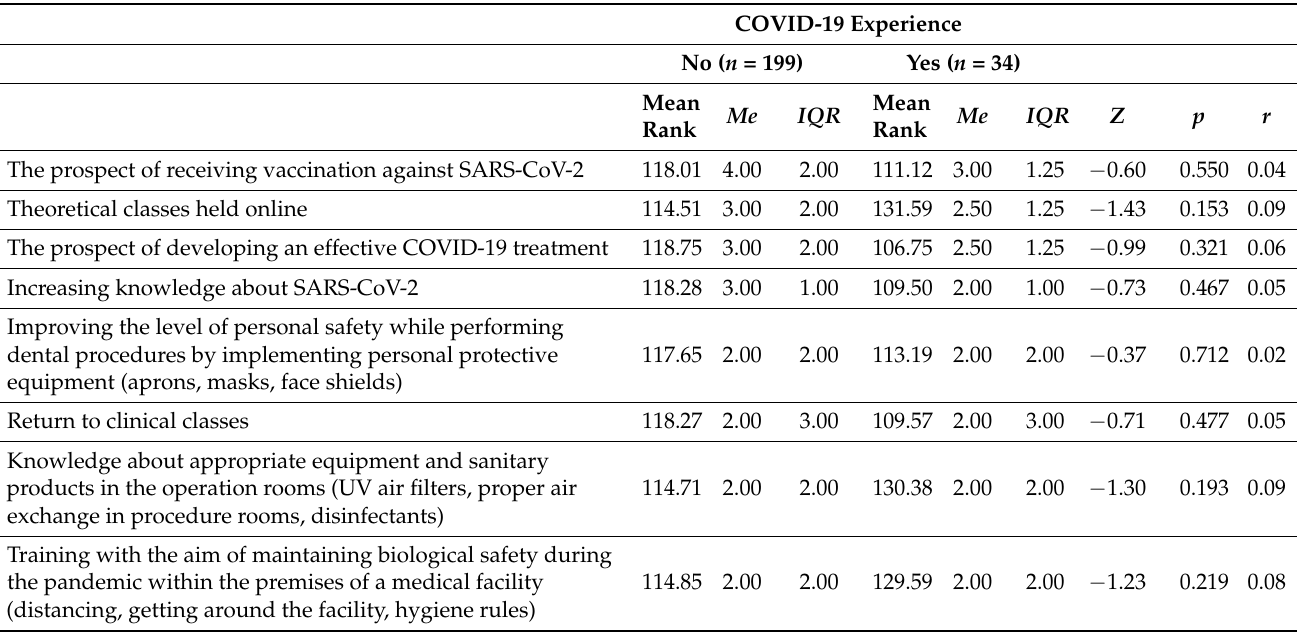
Table 5. Mann–Whitney U test for the comparison of the impacts of the implemented preventive activities on stress perception between volunteers who experienced COVID-19 and students who did not experience COVID-19. Legend: Me —median, IQR —interquartile range, Z